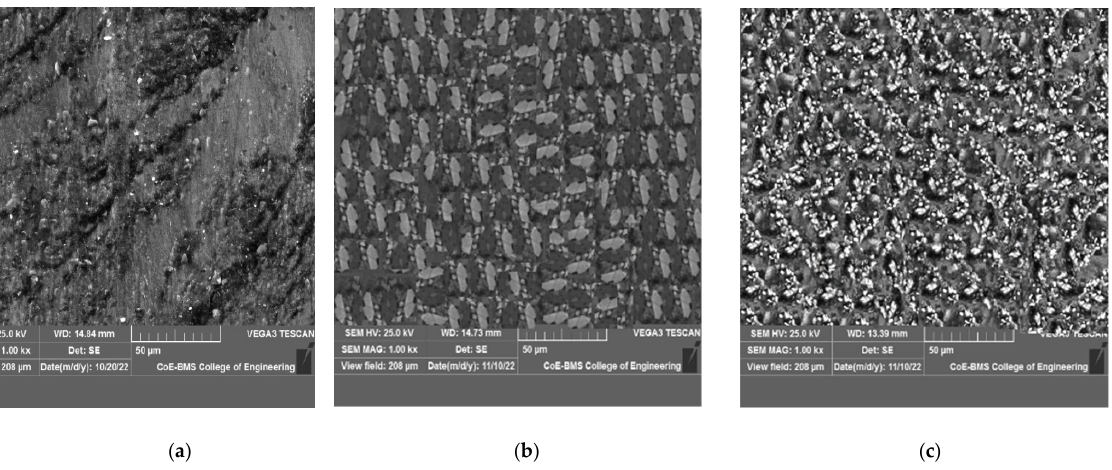
Figure 7. SEM images of a FSPed AA7075/ B 4 C sample prepared at ( a ) 1400 rpm and 45 mm/min, ( b ) 2000 rpm and 25 mm/min, and ( c ) 2000 rpm and 45 mm/min. No defects or porosities were found in the FSPed specimens generated at the different rotational speeds with a constant traverse speed of 45 mm/min, but there was a small quantity of agglomerated n-B 4 C particles, demonstrating that the dispersal of particles in the aluminum matrix was not random. The contact between the surface composite layer and the AA7075 substrate seemed to have few defects. Additionally, it is clear from this figure that the particle dispersion in the specimens created using traverse speeds of 45 mm/min and spin speeds of 1400 rpm were superior to those created using 800 and 1000 rpm or greater speeds of 2000 rpm. This leads to the conclusion that the proper mix of tool rotational and traverse rates is essential to achieving a consistent spread of powder parti- cles. Using low rotational speed or high traversal speed does not improve the B 4 C particle dispersion in the FSP area. The percentage of rotary speed to traversal speed decreases with low rotational velocities or high traverse speeds, which also results in less material stirring.